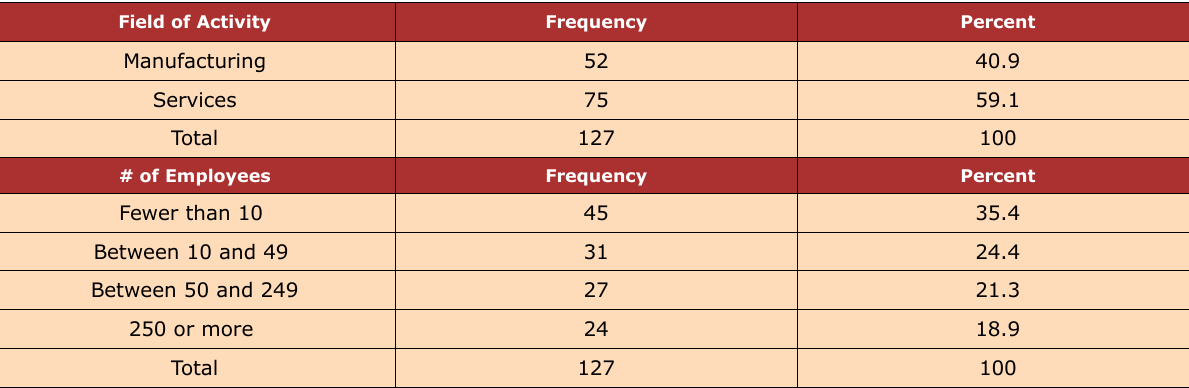
Table 3. Company division by (1) sector/field of activity, and by (2) size/number of